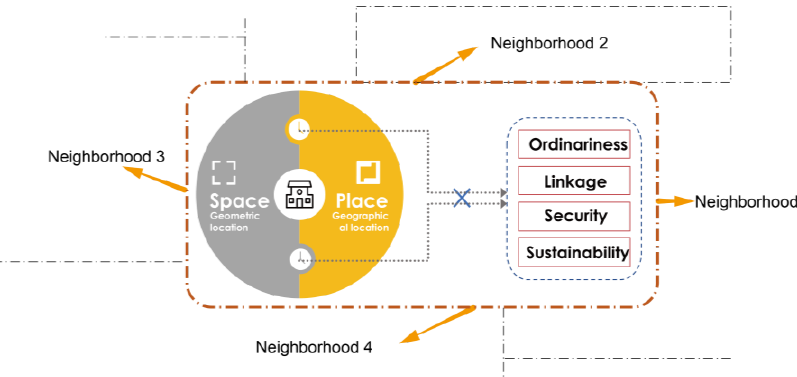
Figure 20. Concept for an Interdisciplinary Network System.